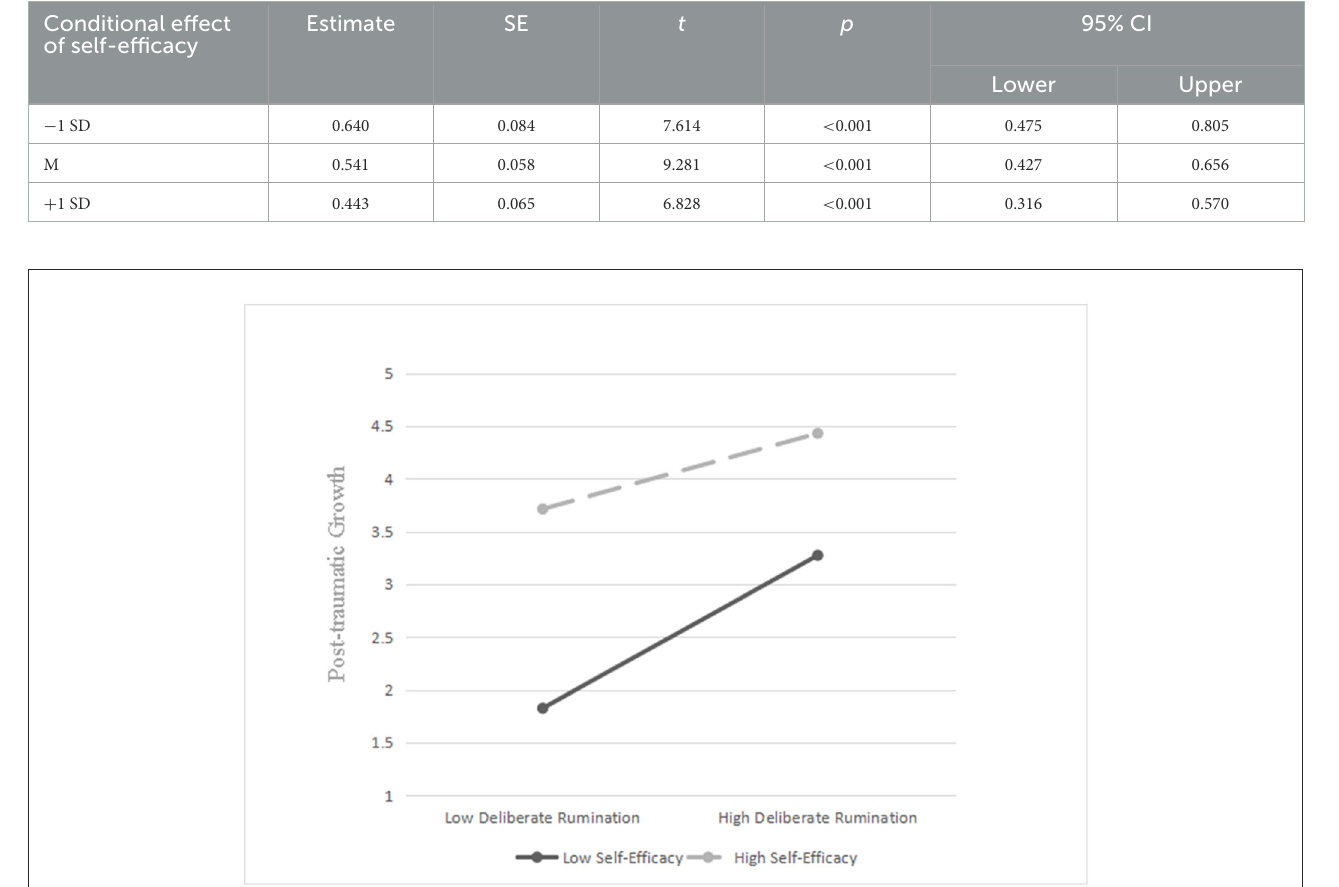
FIGURE2 Relationship between deliberate rumination and post-traumatic growth for high and low levels of